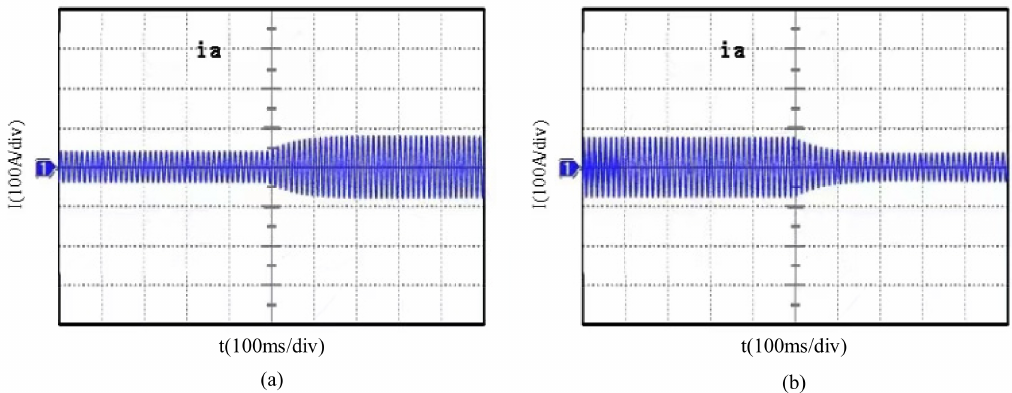
Figure 28. Input current waveforms of load mutation: ( a ) load increases; ( b ) load